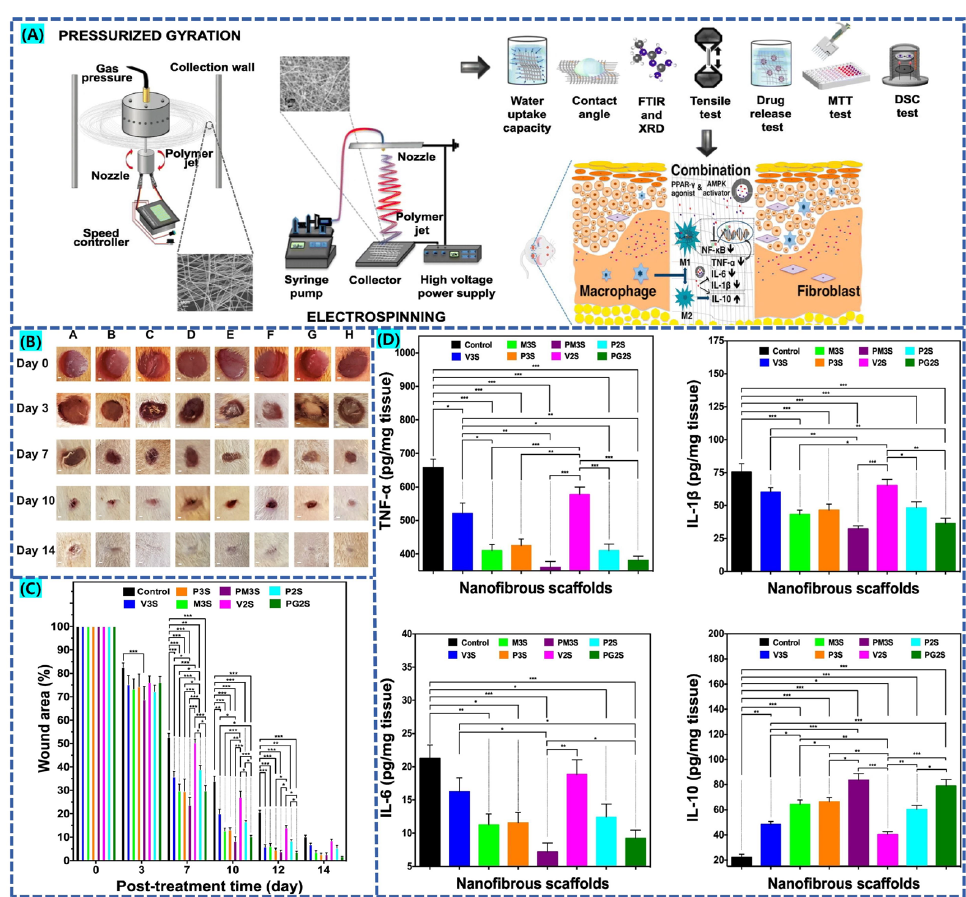
Figure 9. ( A ) Fabrication of drug-loaded nanofiber membranes by different methods, approved citation from ref. [122]. Copyright 2021, Elsevier. ( B ) Statistics on the appearance of wound healing in diabetic rats. ( C ) Results of wound closure experiments in different control groups, approved citation from ref. [122]. Copyright 2021, Elsevier. ( D ) The inflammatory factor levels in the control group and each drug-loaded experimental group. The data is presented as mean ± standard error of the mean. * p < 0.05, ** p < 0.01, *** p < 0.001, approved citation from ref. [122]. Copyright 2021, Elsevier.